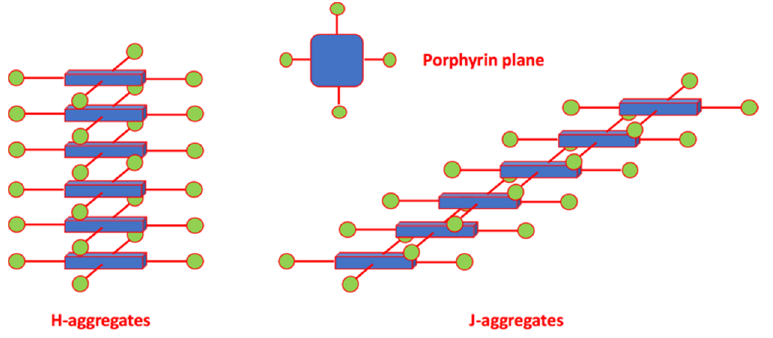
Scheme 3. Idealised cartoon of the limiting molecular morphologies of H ( left ) and J ( right ) porphy- rin